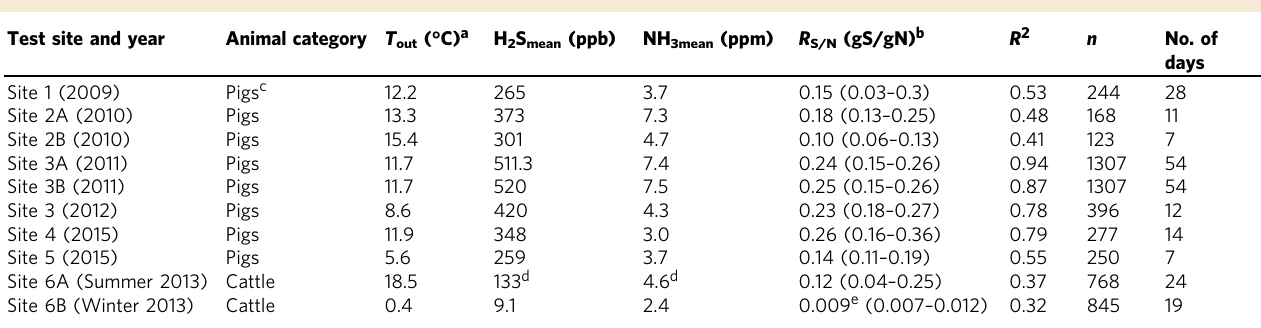
Table 1 Overview of values of R S/N obtained from the data series included in the analysis Test site and